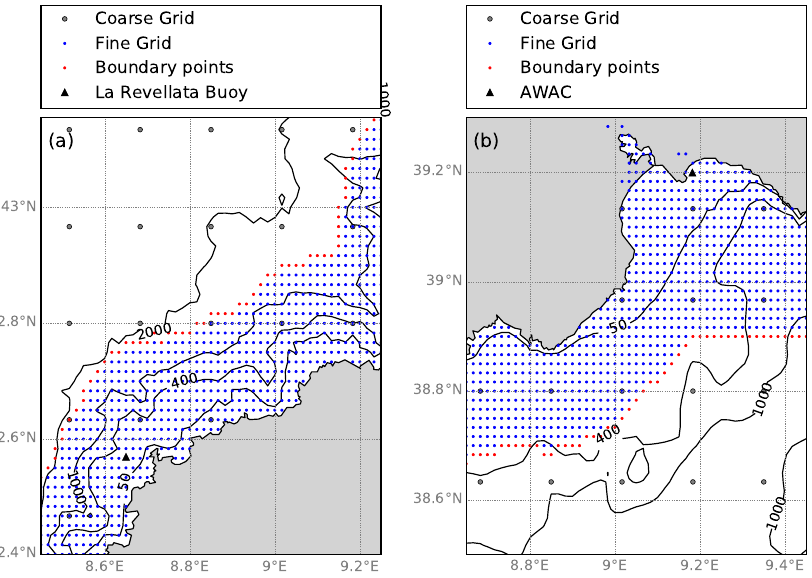
Figure 3. Details of computational grids. ( a ) Corsica; ( b ) Gulf of Cagliari. Thick lines are the coastline, thin lines represent the